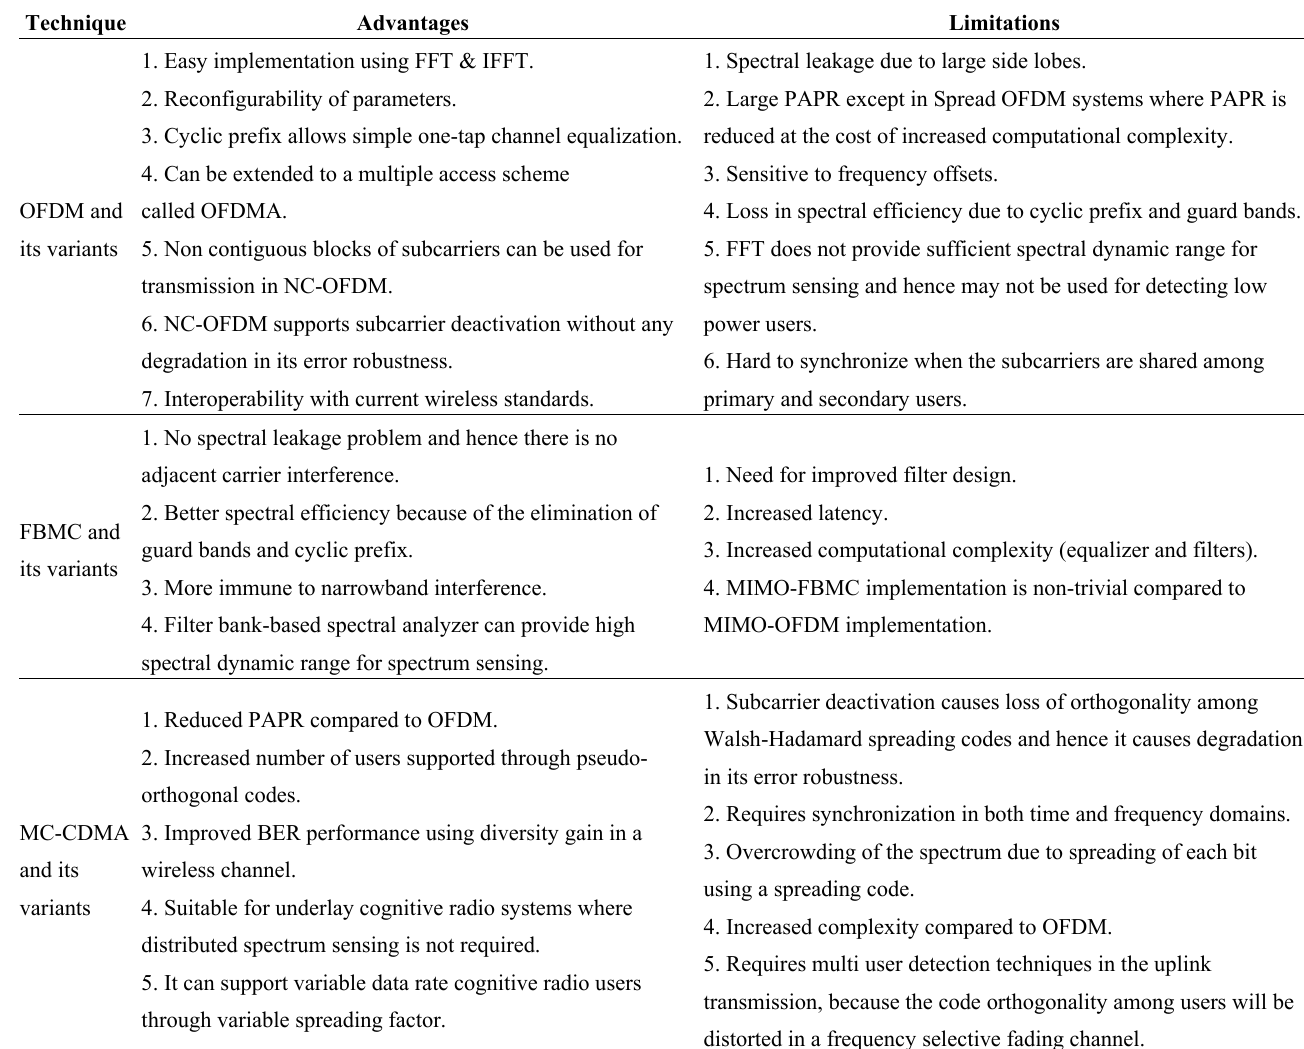
Table 1. Summary of the MCM Schemes for CR Systems: Their Advantages and Limitations. Technique